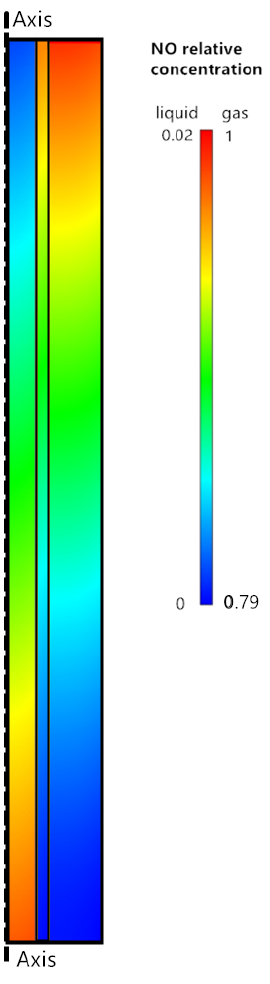
Figure 4. NO distribution contour along porous membrane (benchmark case parameters: feed gas of 185 ppm NO balanced with N 2 ; absorbent of 0.2 wt % H 2 O 2 and 5 wt % NaCl; absorbent flow rate of 40mL min − 1 ; absorption temperature of 343 K; ambient pressure).